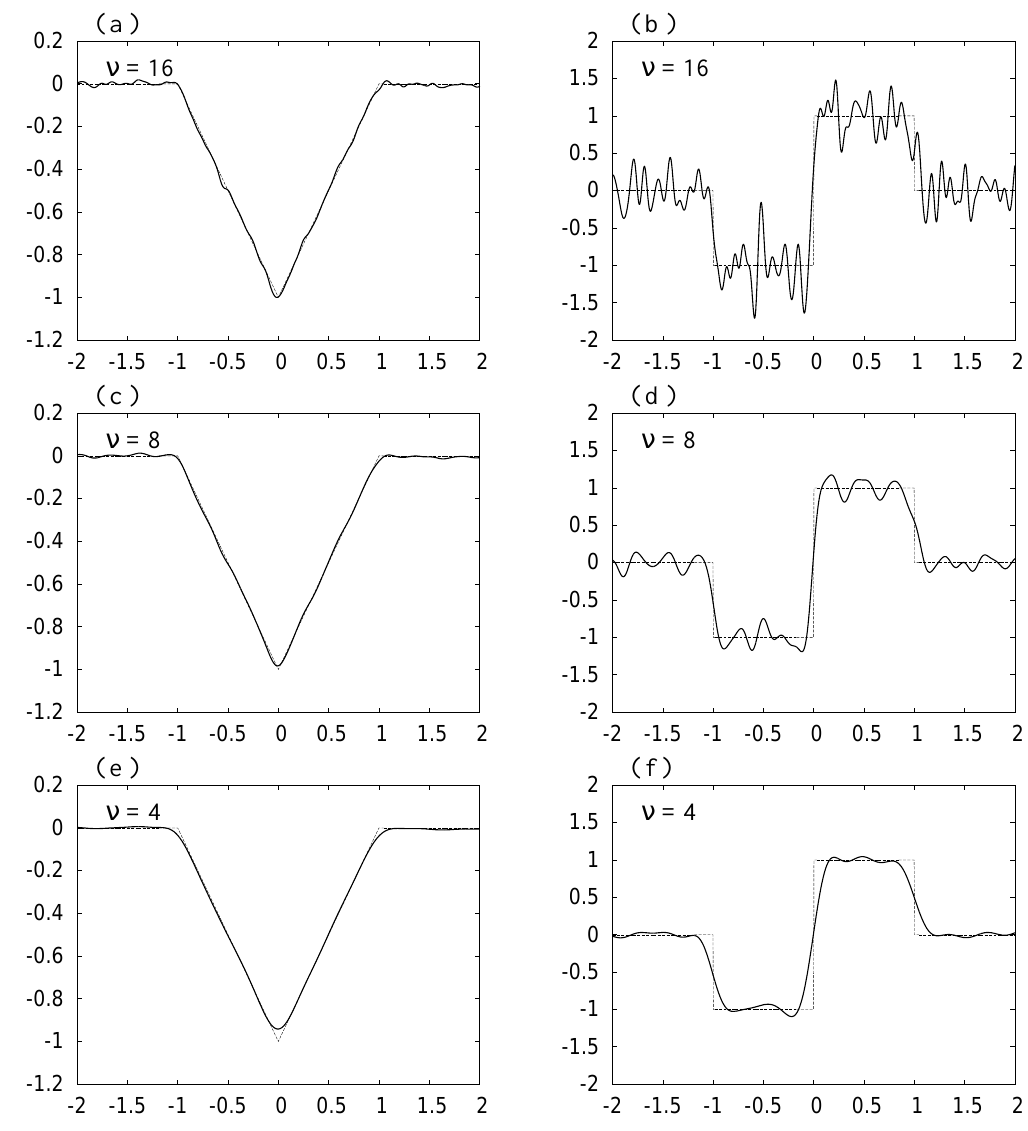
f ( x ) ; ( b ), ( d ), ( f ): ( M ν 1 ,ϵ f ( x ) and ( M ν 1